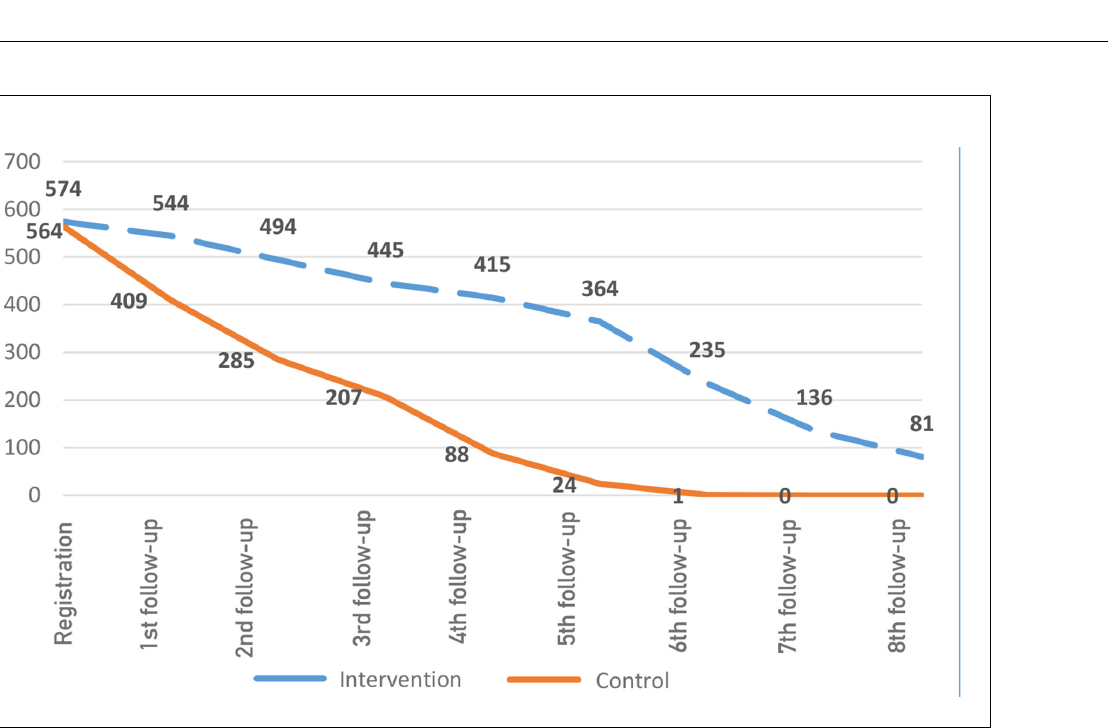
Figure 2. Patient attrition in intervention and control